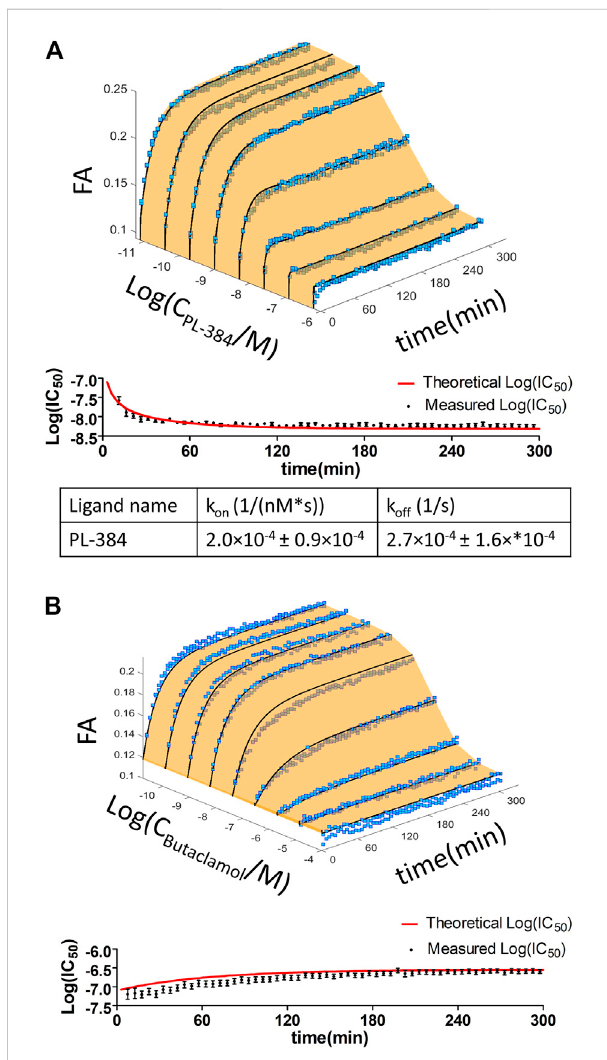
FIGURE 5 Time dependence of the displacement of 1 nM CELT-419 by increasing concentrations of PL-384 (A) and Butaclamol (B) obtained from FA competition binding experiments. Data of representative experiments performed in duplicate are shown. The light orange surface and black curves indicate the global fi t of the single binding site model to the data from FA experiments. Log(IC 50 ) ± SE values obtained from three-parameter sigmoidal dose response model of the raw FA measurement data (black circles) and of the global fi tted data (red line), calculated at different incubation times, are shown in thelower panel of therespective graphs. k on and k off values shown are given as mean ± SEM of three